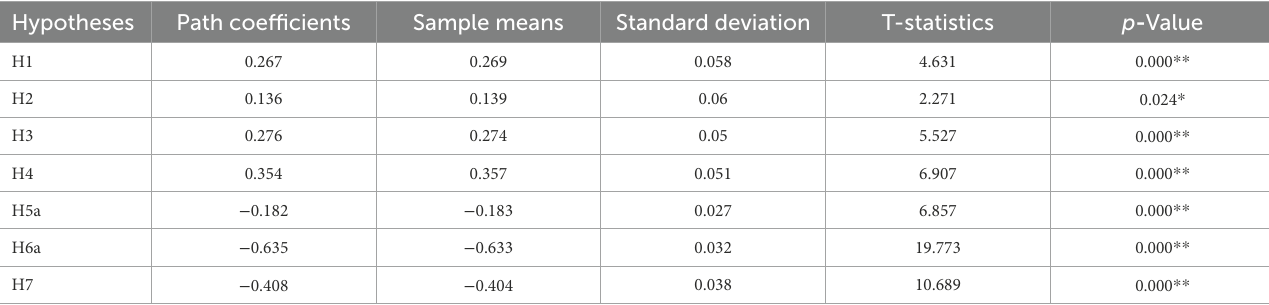
TABLE 13 Results of direct effect